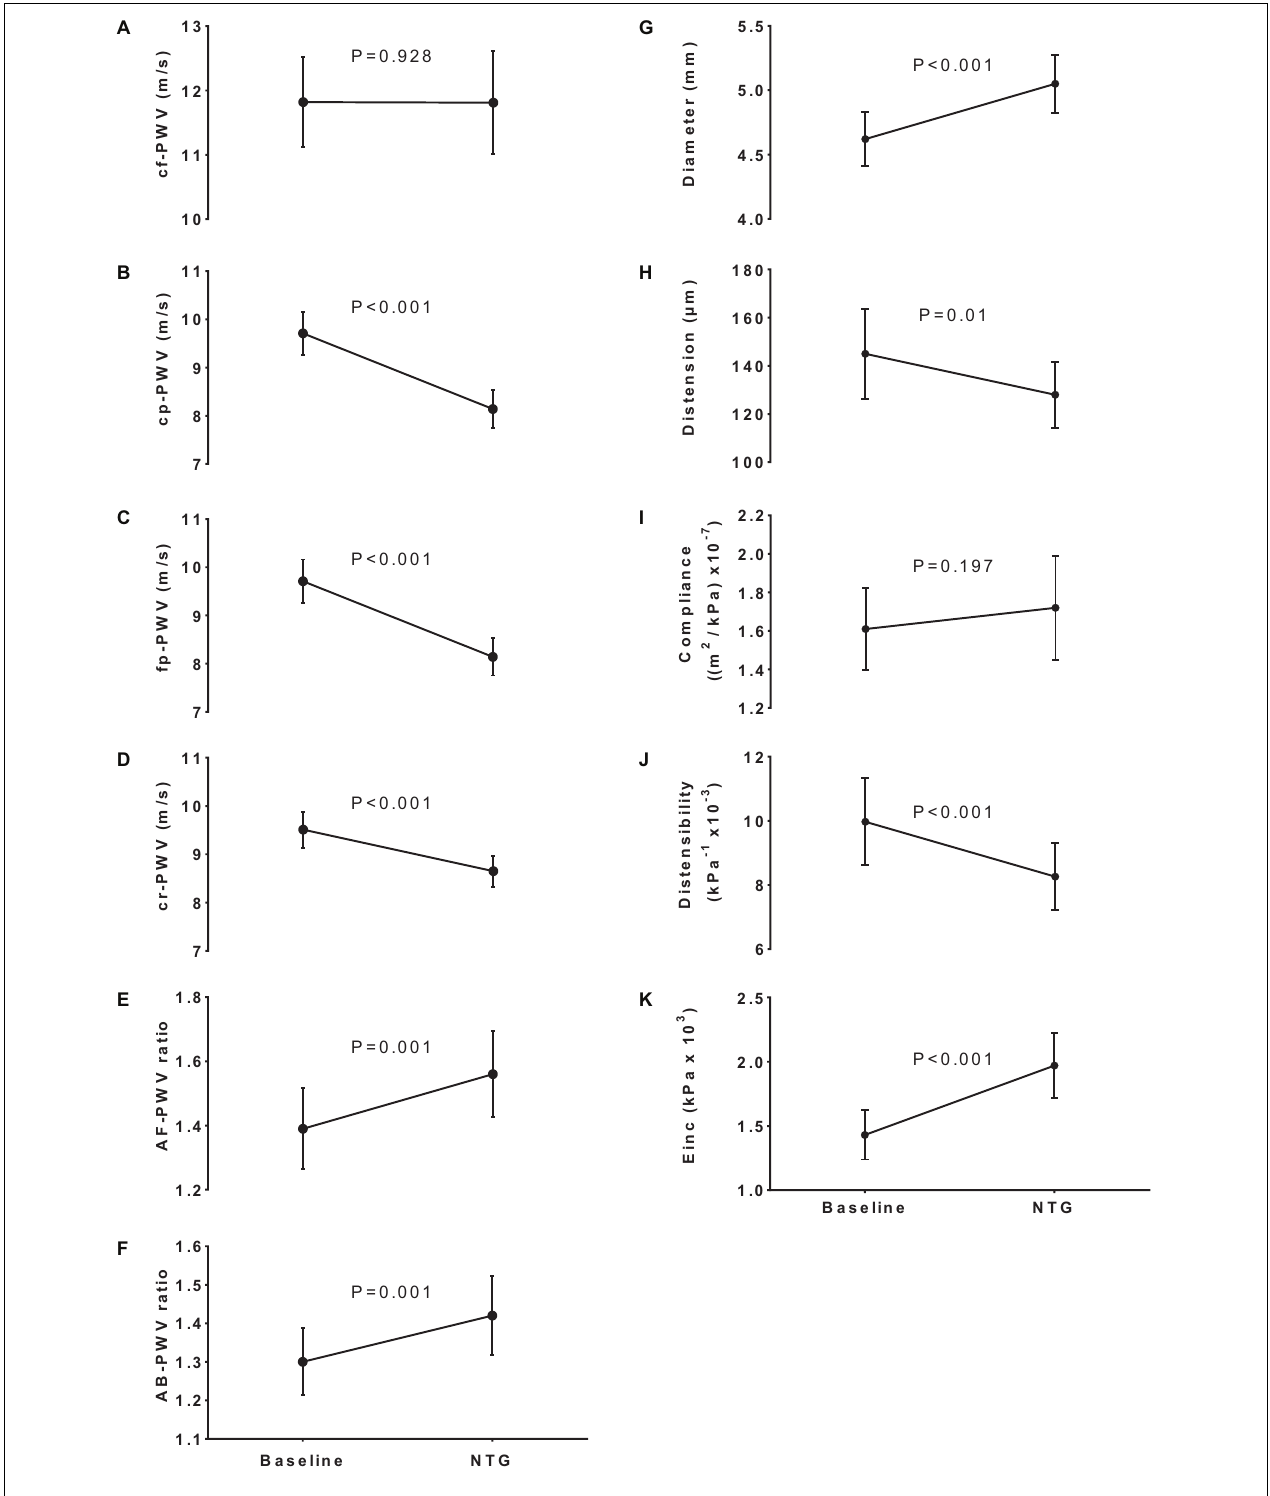
FIGURE 1 | Impact of NTG on regional stiffness, arterial stiffness gradients, and local brachial stiffness parameters. Panels (A–D) show the effect of nitroglycerin (NTG) on pulse wave velocity of various territories (PWV). The NTG had no effect on carotid-femoral PWV (cf-PWV) but significantly decreased carotid-pedis PWV (cp-PWV), femoral-pedis PWV (fp-PWV), and carotid-radial PWV (cr-PWV) leading to a corresponding increase in aortic-femoral PWV ratio [AF-PWV ratio (E) ] and aortic-brachial PWV ratio [AB-PWV ratio (F) ]. Changes in the brachial artery diameter (G) , distention (H) , compliance (I) , distensibility (J) , and incremental elastic modulus [E inc , (K) ] in response to